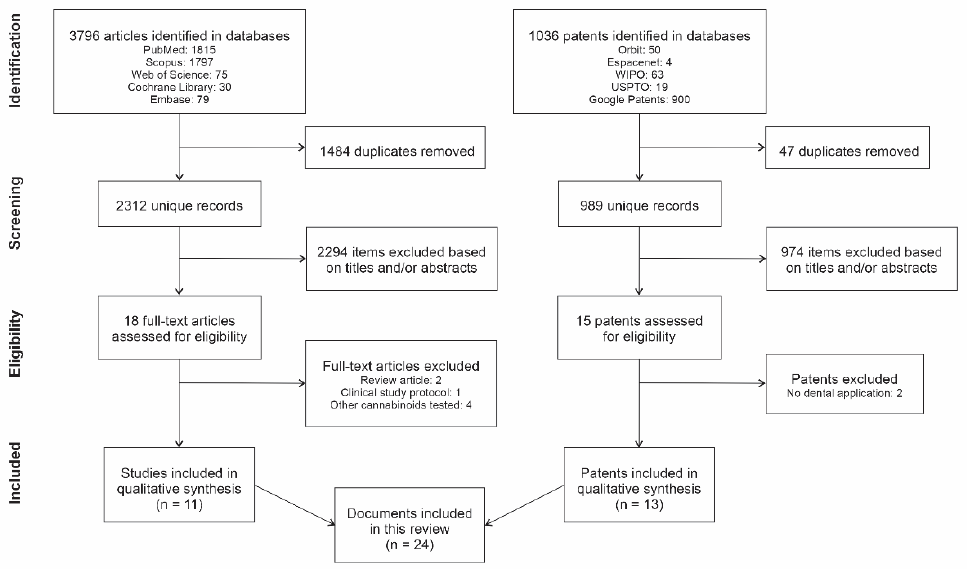
Figure 1. Flowchart of the selection process of articles and patents.